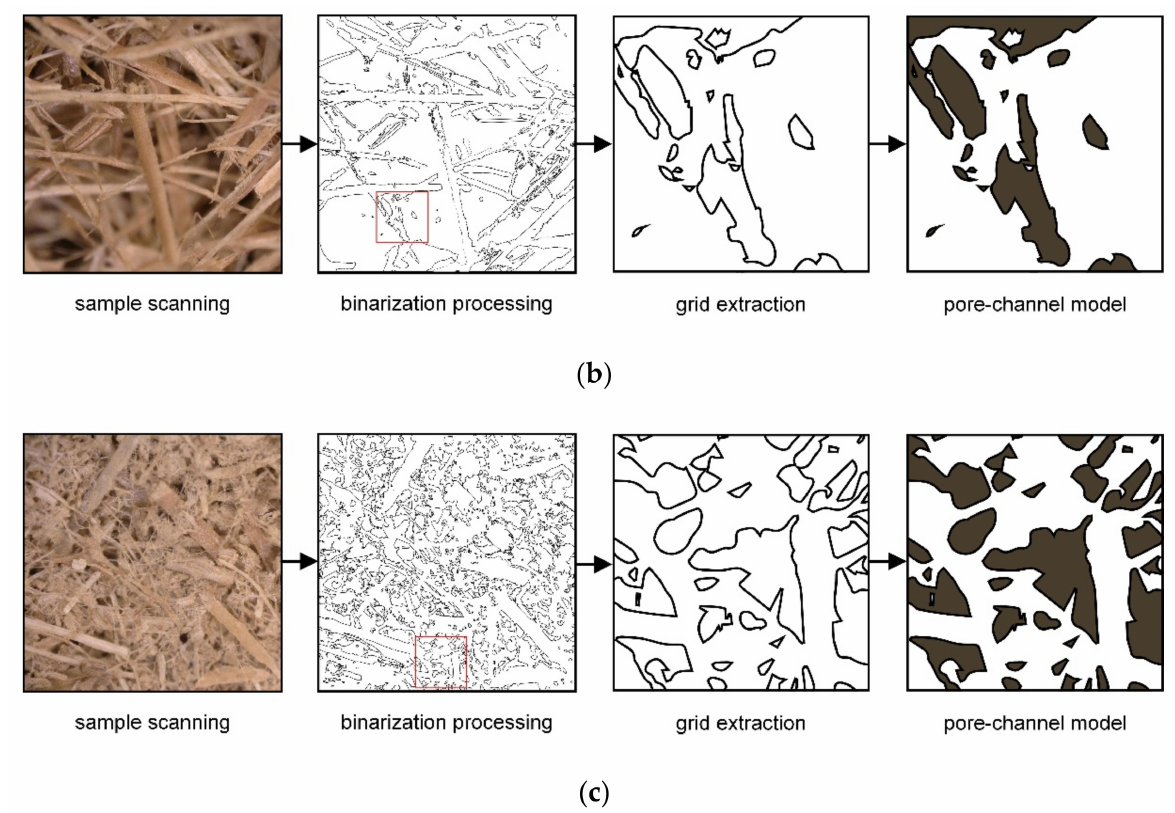
Figure 13. The process of sample pore channel modeling. ( a ) Pore channel model establishing of the tensile index (70.2 N · m · g − 1 ) sample. ( b ) Pore channel model establishing of the tensile index (85.9 N · m · g − 1 ) sample. ( c ) Pore channel model establishing of the tensile index (112.5 N · m · g − 1 )